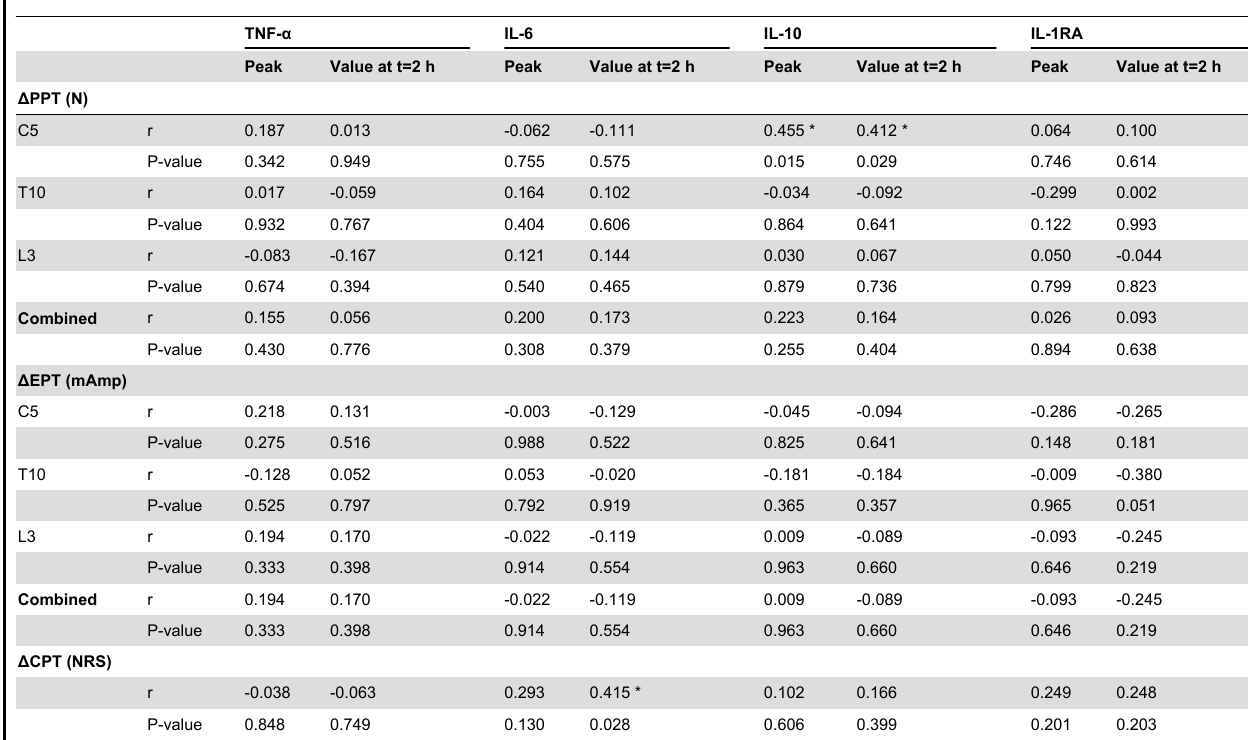
Table 2. Spearman correlations of changes in pain thresholds and